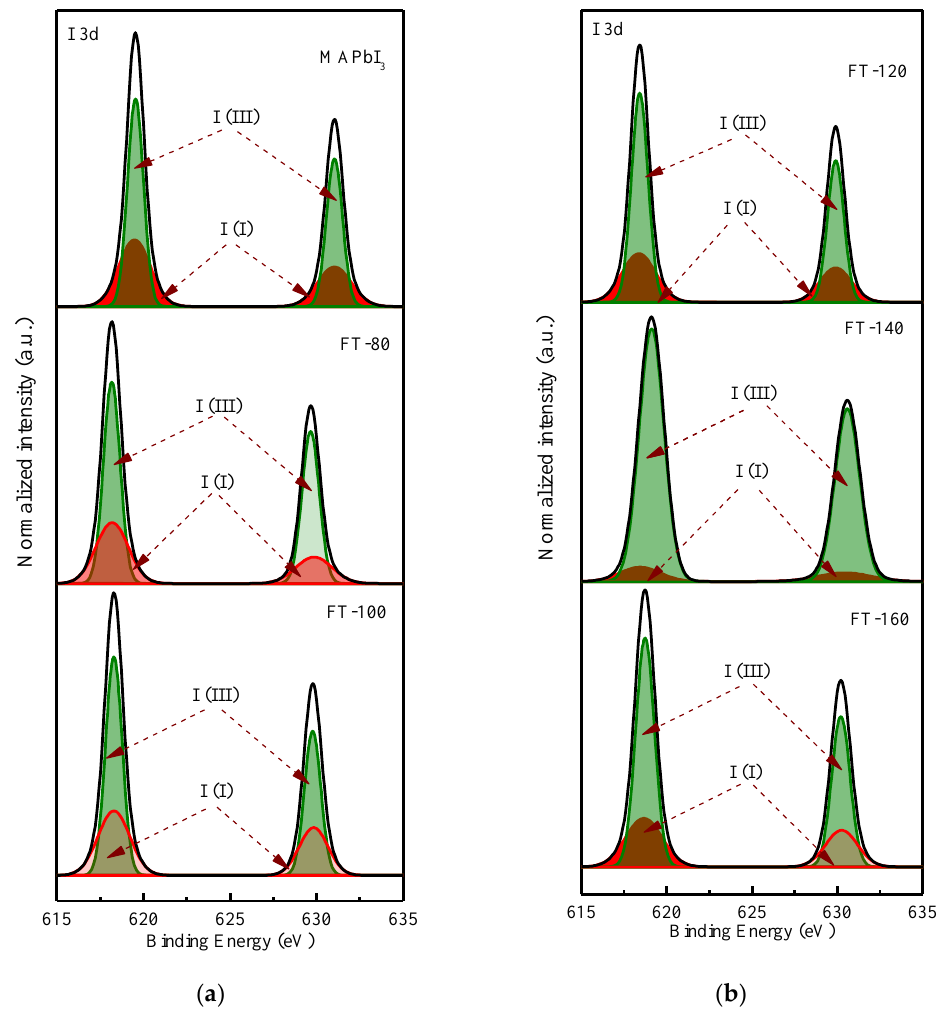
Figure 4. XPS core-level spectra of I 3d ( a ) Pristine MAPbI 3 and CsPbI 3 -QD doped MAPbI 3 under different filming temperatures (FTs) from 80 to 100 ◦ C. ( b ) CsPbI 3 -QD doped MAPbI 3 under different filming temperatures (FTs) from 120 to 160 ◦